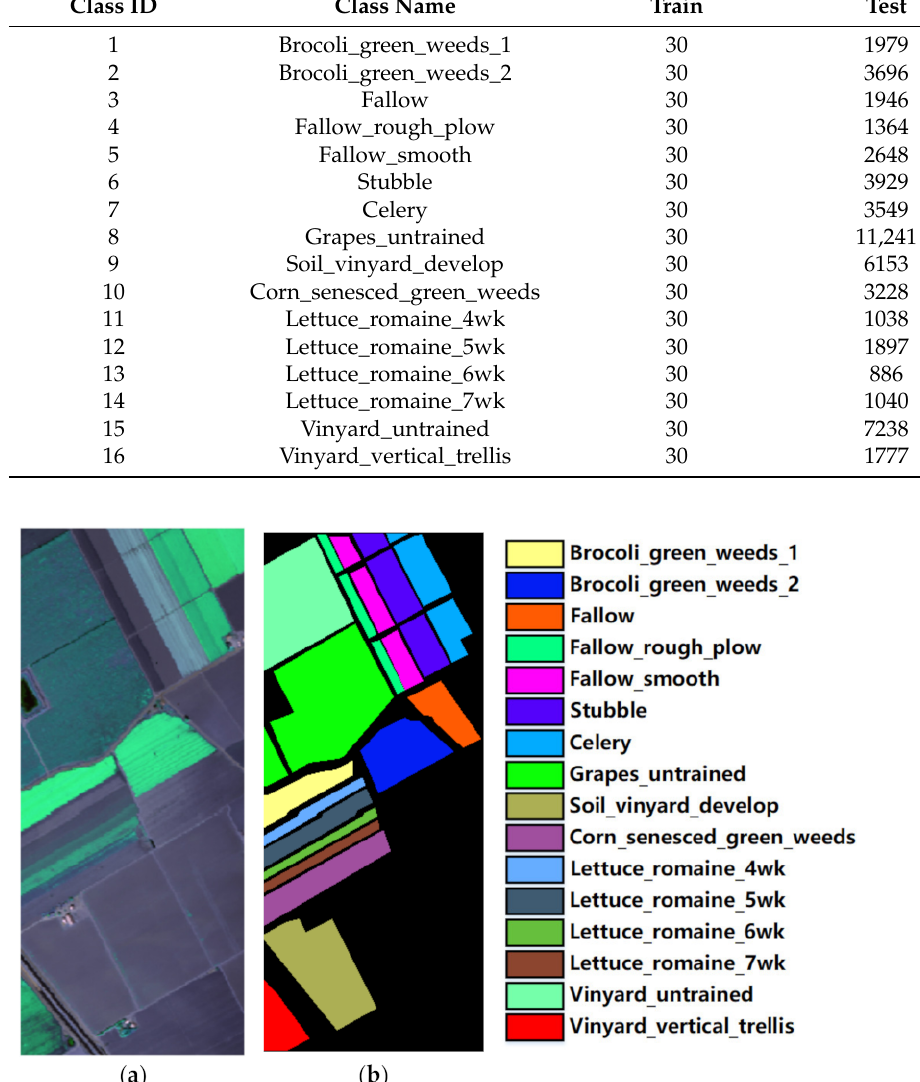
Figure 10. Salinas. ( a ) False-color image. ( b ) Ground-truth